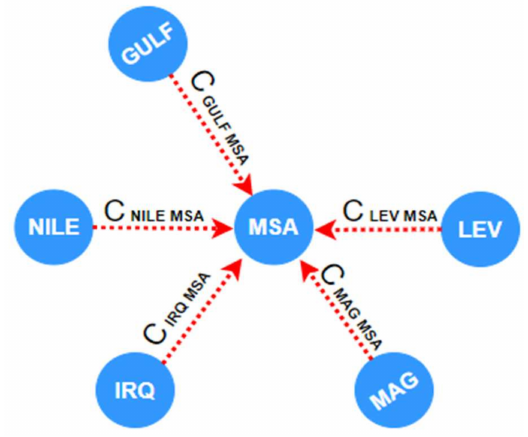
Figure 3. Translation graph: Arabic dialects (nodes), Parallel Corpora (dotted